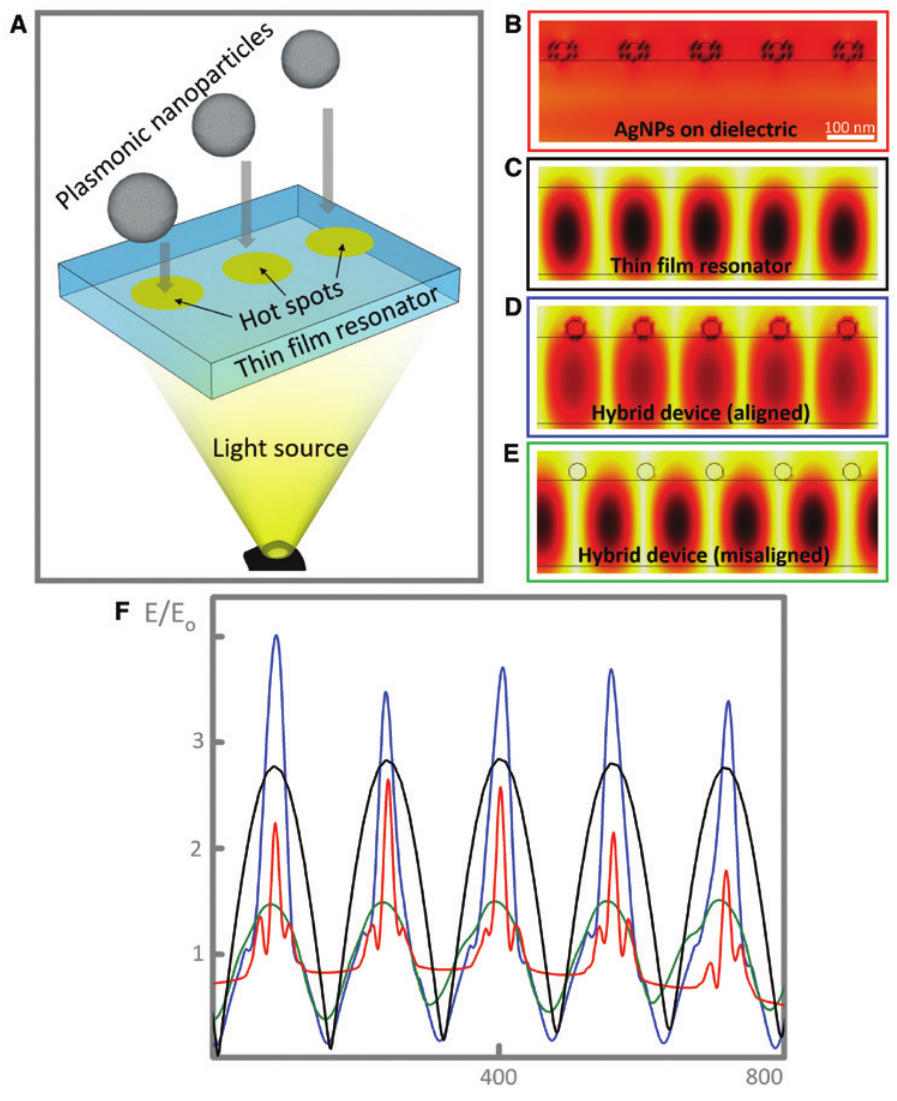
Figure 1: The benefit of maximized interaction between the plasmonic nanoparticles and thin film resonator in a hybrid device. (A) Schematic illustration of the challenge related to hybrid optics in positioning of plasmonic nanoparticles at the hot spots of a large-area thin film resonator. (B) 20 nm AgNPs placed on a dielectric substrate. (C) Standing electromagnetic wave inside the thin film resonator. (D) 20 nm AgNPs placed on the thin film resonator at the maximum of evanescent field strength. (E) 20 nm AgNPs placed on the thin film resonator and shifted to the positions of minimum evanescent field strength. (F) Electric field strength on the surface of the dielectric with AgNPs on top (red curve), thin film resonator without AgNPs (black curve), aligned (blue curve) and misaligned (green curve) hybrid